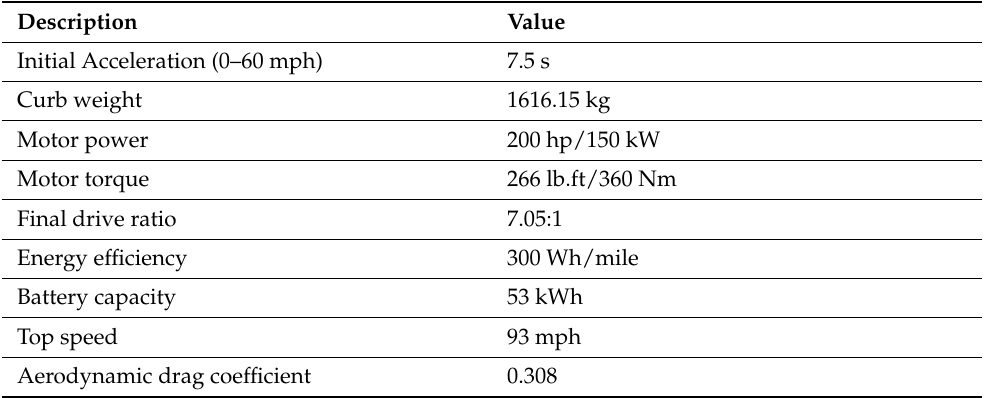
Table 1. Vehicle Specification for Chevrolet Bolt